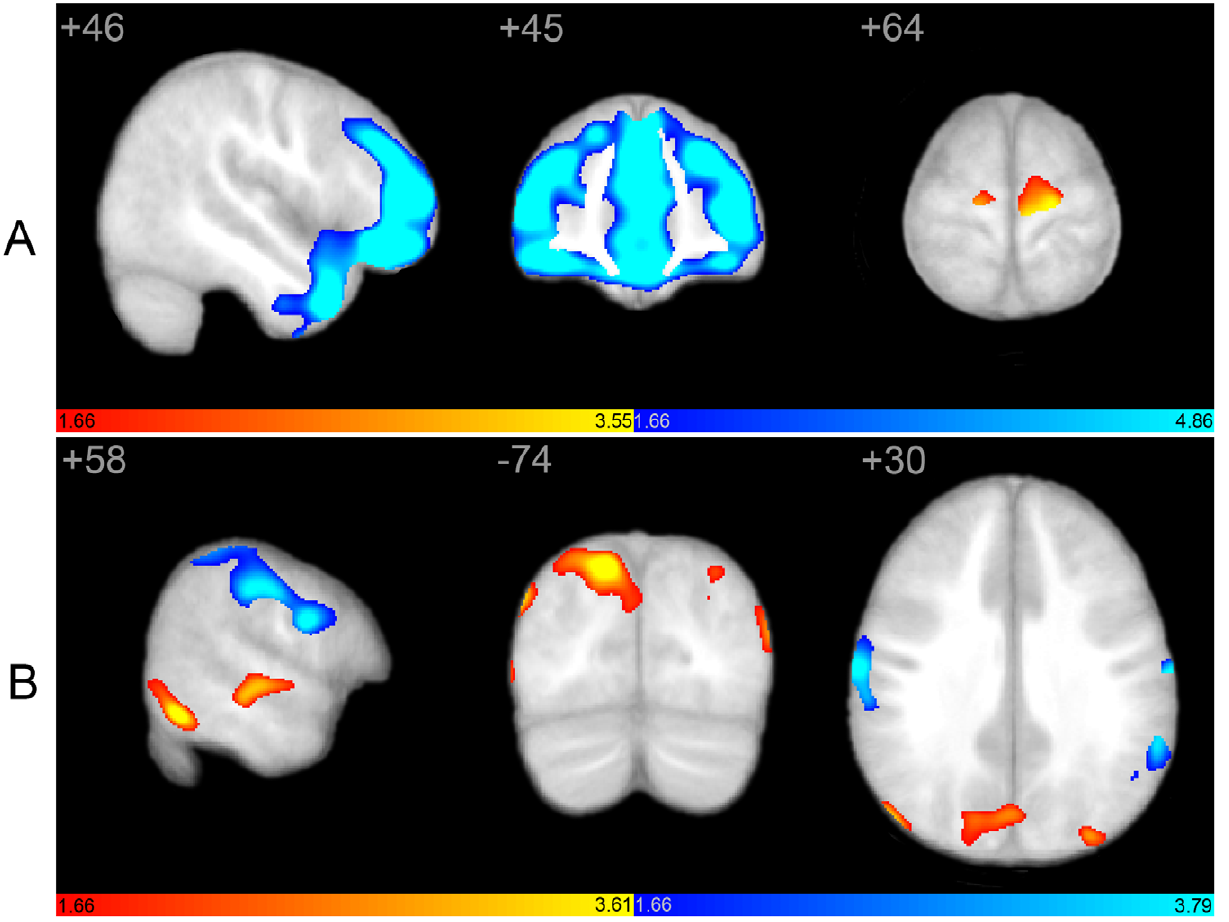
Figure 4. Structural covariance maps of salience and default mode networks as a result of direct between-group contrasts. Statistical parametric maps depict brain regions in which gray matter intensity covaried with that of the seed ROI (right FI or PCC) differently between groups. (A) Structural covariance with right FI is greater in bilateral SMA in autistic subjects (hot colors; see also Table 3), whereas control subjects (cool colors) demonstrate more robust covariance in extensive frontal and temporal brain regions, in addition to insular cortex. Covariance outside of canonical SN boundaries is evidenced only in the autistic group. (B) Structural covariance with right PCC includes posterior cingulate, parieto-occipital, and temporal brain regions in autism (hot colors), whereas frontal covariance is absent. In contrast, control subjects demonstrate more robust covariance in frontal, lateral inferior parietal, and paracentral regions (cool colors; see also Table 3). Covariance outside of canonical DMN boundaries is evidenced only in the autistic group. scMRI data are T-statistic maps (p , 0.05, inclusively masked to the network global map for both groups at p , 0.01 FWE) displayed on the average anatomical template of all subjects. The left side of the image corresponds to the right side of the brain. DMN, default mode network; FI, frontoinsula; FWE, family-wise error; PCC, posterior cingulate cortex; ROI, region of interest; SN, salience